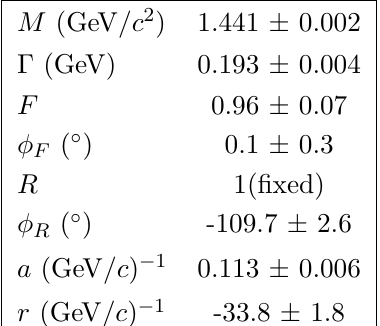
Table 4 . The Kπ S-wave parameters, obtained from the amplitude analysis of D 0 → K 0 the BABAR and Belle experiments [37]. Uncertainties are statistical